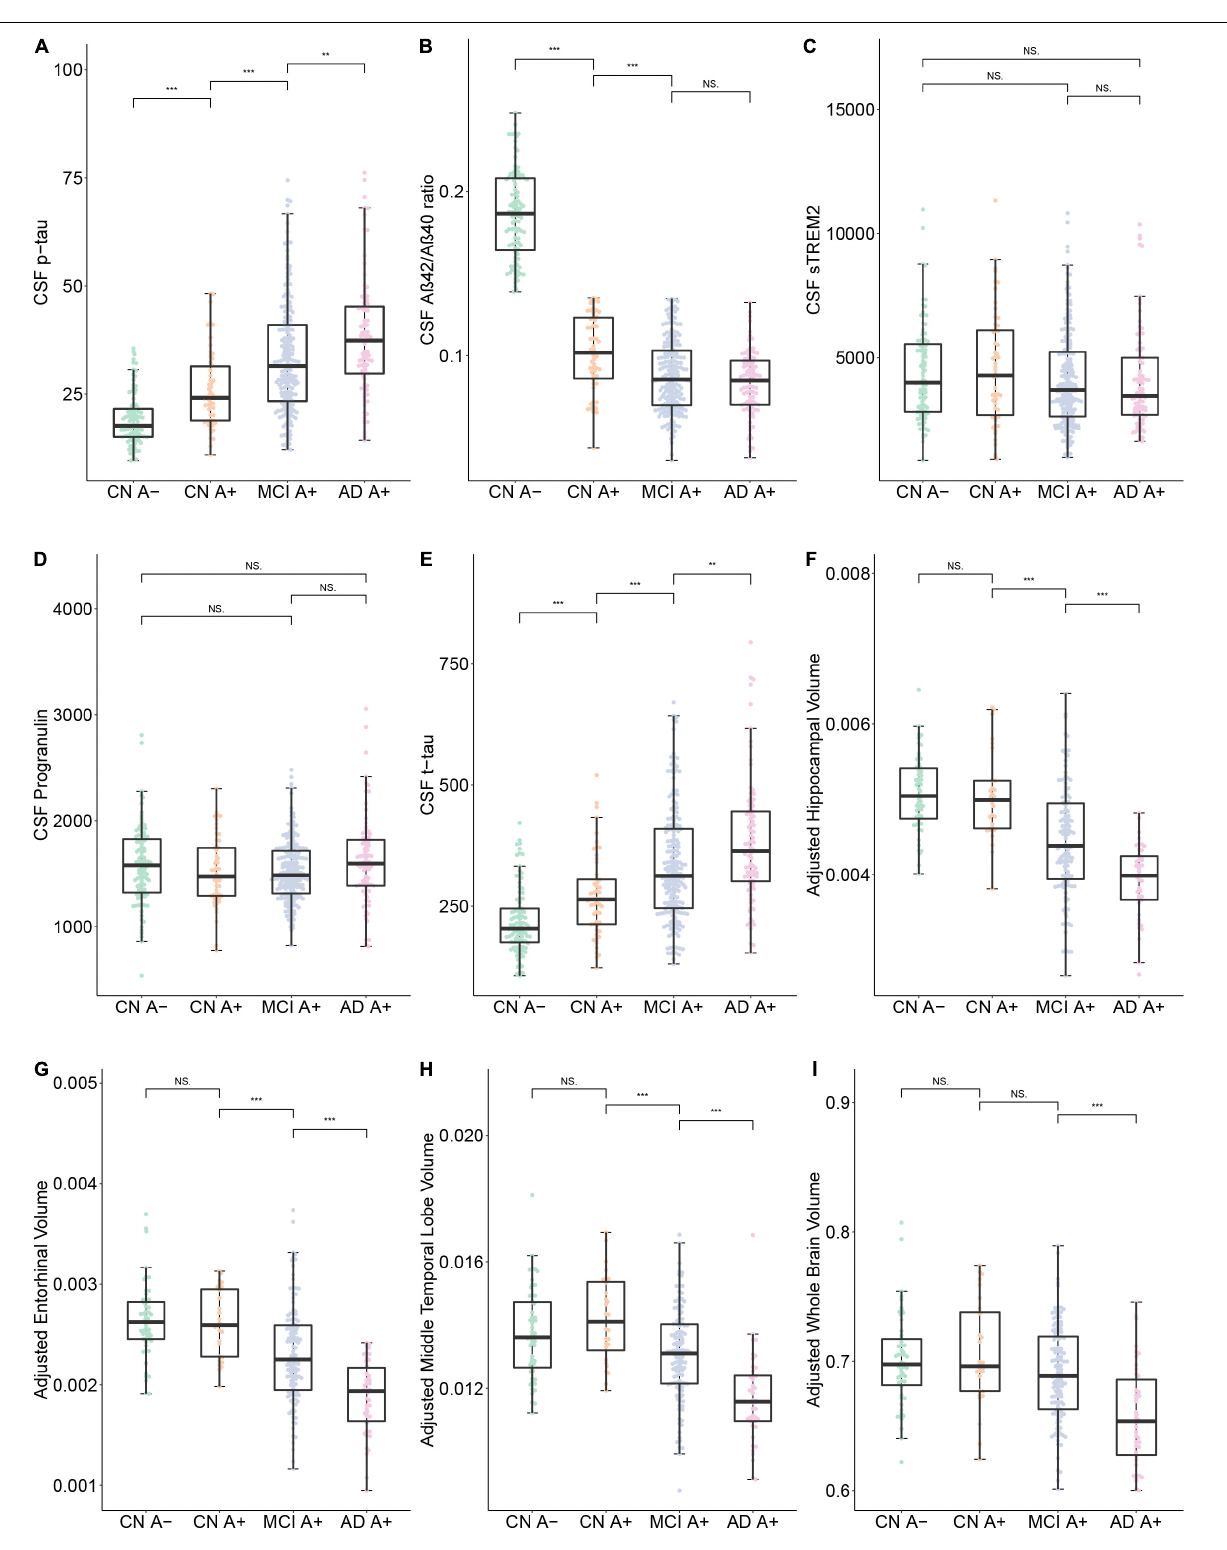
FIGURE 1 | Baseline data comparison between CN A-, CN A+, MCI A+, and AD A+ groups. (A–I) Show the baseline Cerebrospinal Fluid (CSF) protein concentrations and specific brain region volumes in each group. Note that the brain volumes were computed using 3.0 T structural MRI. *** p < 0.001, ** p < 0.01, * p < 0.05, ns, not